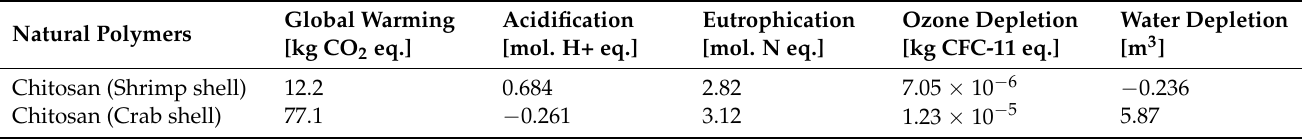
Table 5. The LCA results of chitosan natural polymers